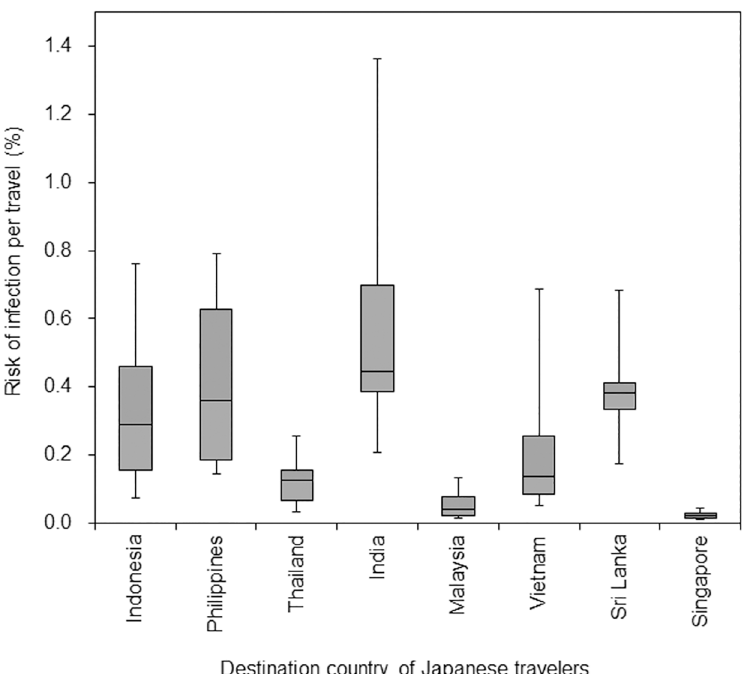
Fig 4. Estimated risk of dengue virus infection among Japanese travelers from 2006 to 2016 by destination country. Box whisker plot shows the range of estimated risk of infection per journey from 2006 to 2016. Middle line of box represents median, extending from lower to upper quartiles. Whiskers extend to lowest and highest risks.